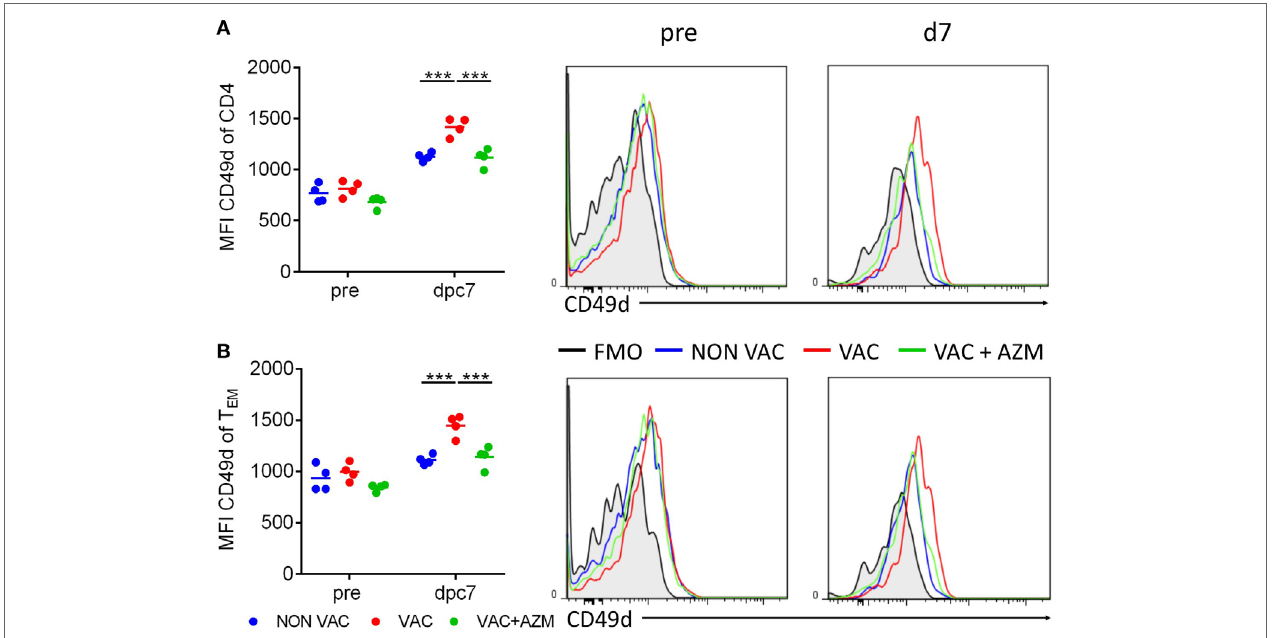
FigUre 6 | Azithromycin treatment during immunization leads to reduced CD49d expression on splenic CD4 T cells. Mice received azithromycin or vehicle during immunization with whole cell pertussis vaccine 6 and 2 weeks before aerosol challenge with Bordetella pertussis . CD49d expression on CD4 T cells (a) and CD4 T EM T cells (B) in the spleen were analyzed 1 day before (pre) and 7 dpc via flow